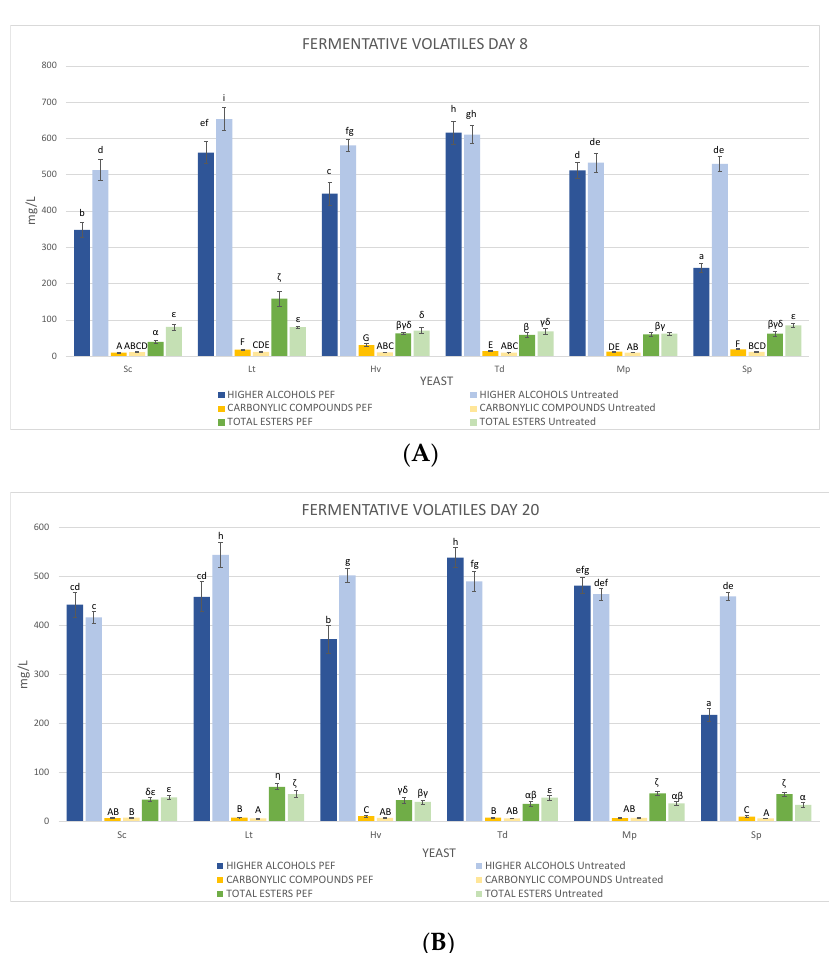
Figure 6. Fermentative volatiles in wines obtained from untreated and PEF-treated musts/wines. ( A ) Day 8 and ( B ) day 20. Values are means ± sd ( n = 3). A different letter (lowercase, capital and Greek letters) for the same category of volatiles means significant differences ( p < 0.05).